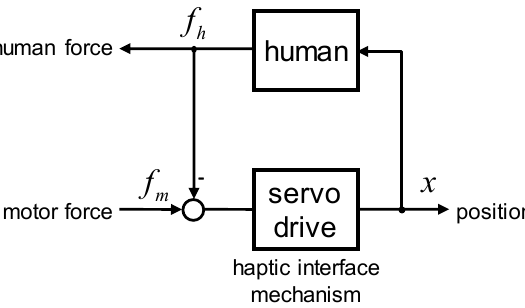
Figure 8. The basic system block scheme for control design of the haptic interface.